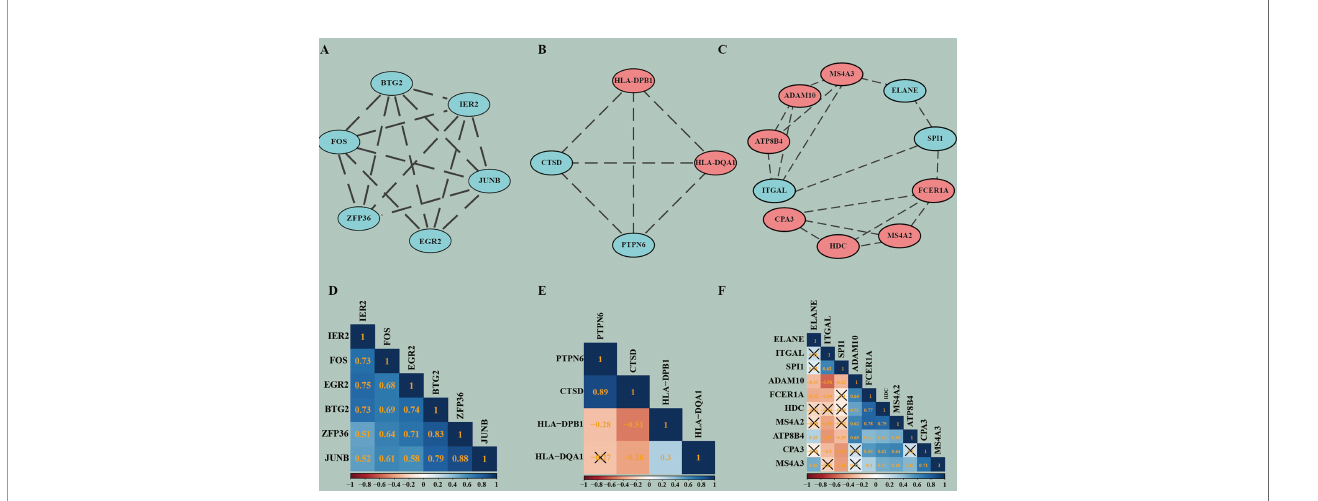
FIGURE 5 | The highly connected modules of PPI and the correlation matrix corresponding to each module. (A – C) Modules of PPI network. (D – F) Correlation matrixes of highly connected genes in each module. In the modules, red represents genes that are upregulated and blue represents genes that are downregulated. In the correlation analysis, blue indicates positive correlations, red indicates negative correlations, and higher values indicate higher correlations. Squares marked with a cross indicate that the correlation analysis between genes is not statistically signi fi cant (P >